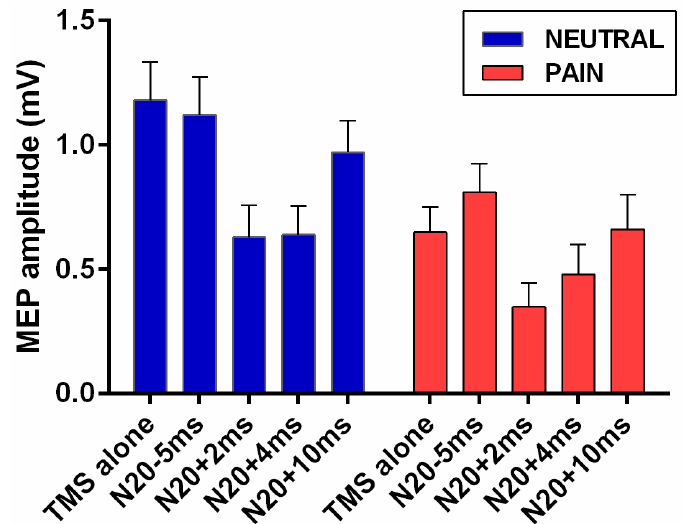
Figure 3. MEP amplitude as a function of Condition and Stimulation Interval. The average MEP amplitude for TMS alone and each of the four ISIs is shown separately for the NEUTRAL and PAIN conditions. Error bars indicate the standard error of the mean.